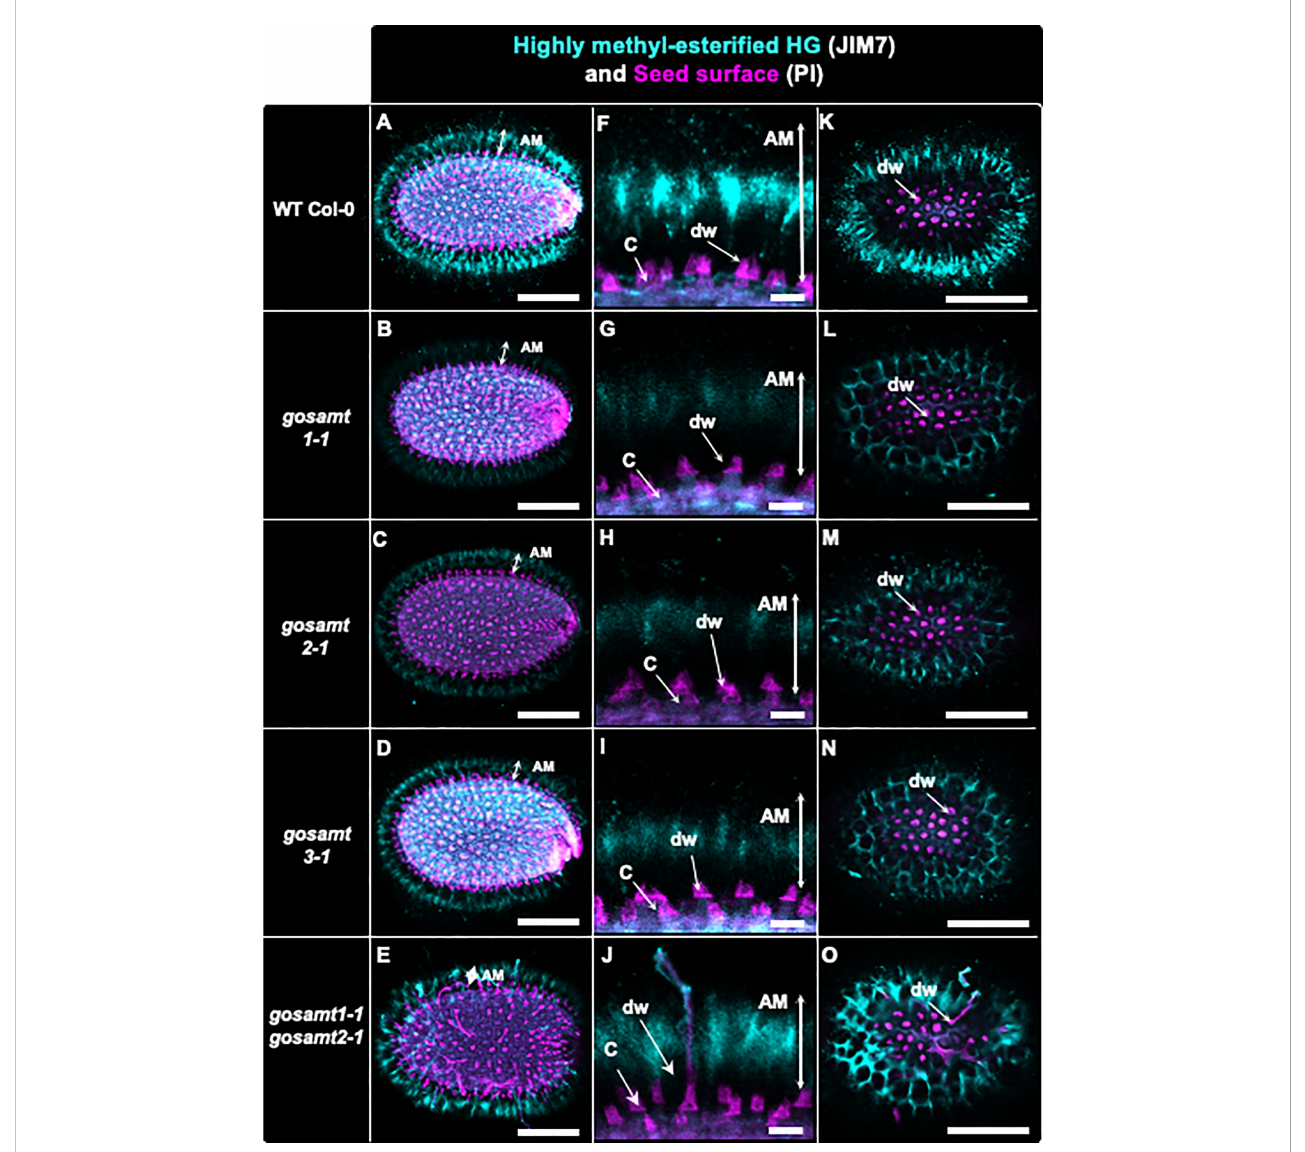
FIGURE 5 Distribution of highly methyl-esteri fi ed homogalacturonans recognized by JIM7 antibody in adherent mucilage layers of wild-type and gosamts mutants. Confocal microscopy images of AM released from WT Col-0 and gosamts mutants mature imbibed seeds. Fluorescence corresponds to JIM7 antibody labelling in cyan, and propidium iodide, used to detect the seed surface in magenta. (A – E) Different optical planes showing entire seed. (F – J) Close-up of columella. (K – O) Top view of seed surface. C = columella; dw = distal cell wall; vertical arrows in (F – J) indicate labelled AM. Scale bars: (A – E) and (K – O) = 200 µm; (F – J) =50